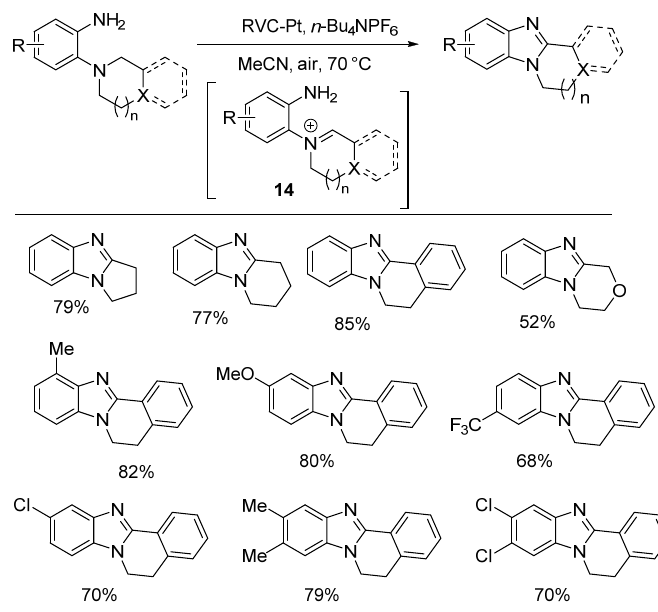
Scheme 8. Electrochemical oxidative cyclizations